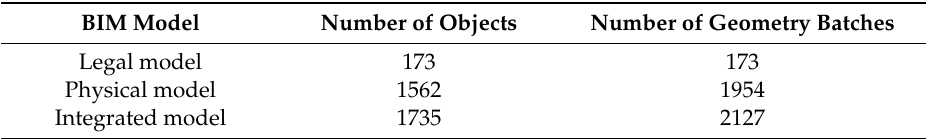
Table 1. Number of objects and geometry batches in each BIM